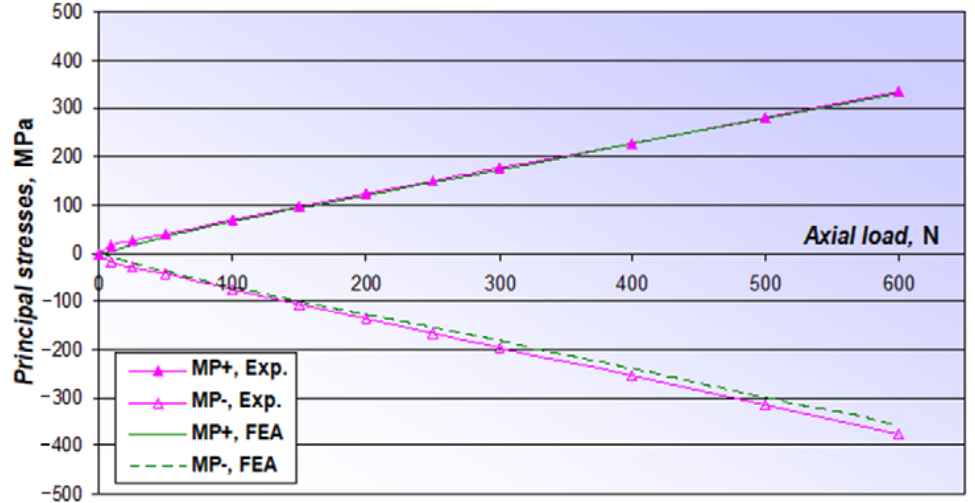
Figure 10. Comparative diagram of the principal stresses ( σ 1 on MP+) and ( σ 3 on MP − ).